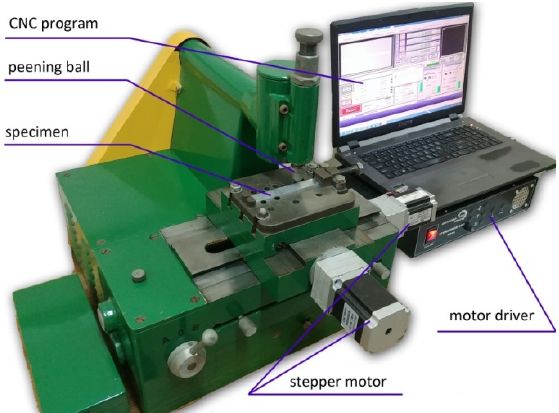
Figure 3. View of the RSP and SRSP test stand.